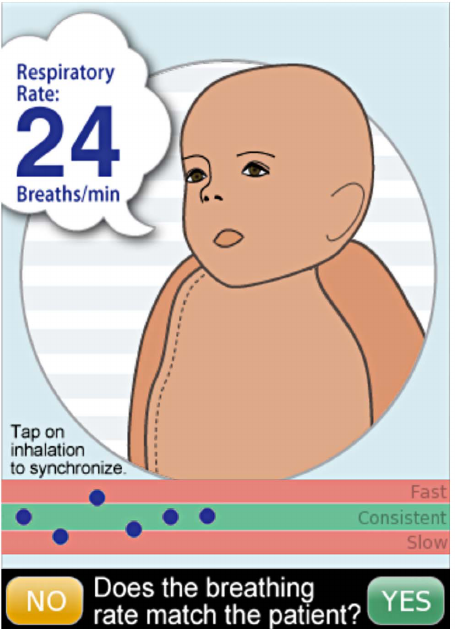
Figure 3. Screenshot of feedback screen of the RRate applica- tion. An animated (chest, shoulder and mouth) baby presents the RR. The timing of the animation can be reset with a tap. The consistency of the tap intervals is displayed on the bottom of the screen as blue